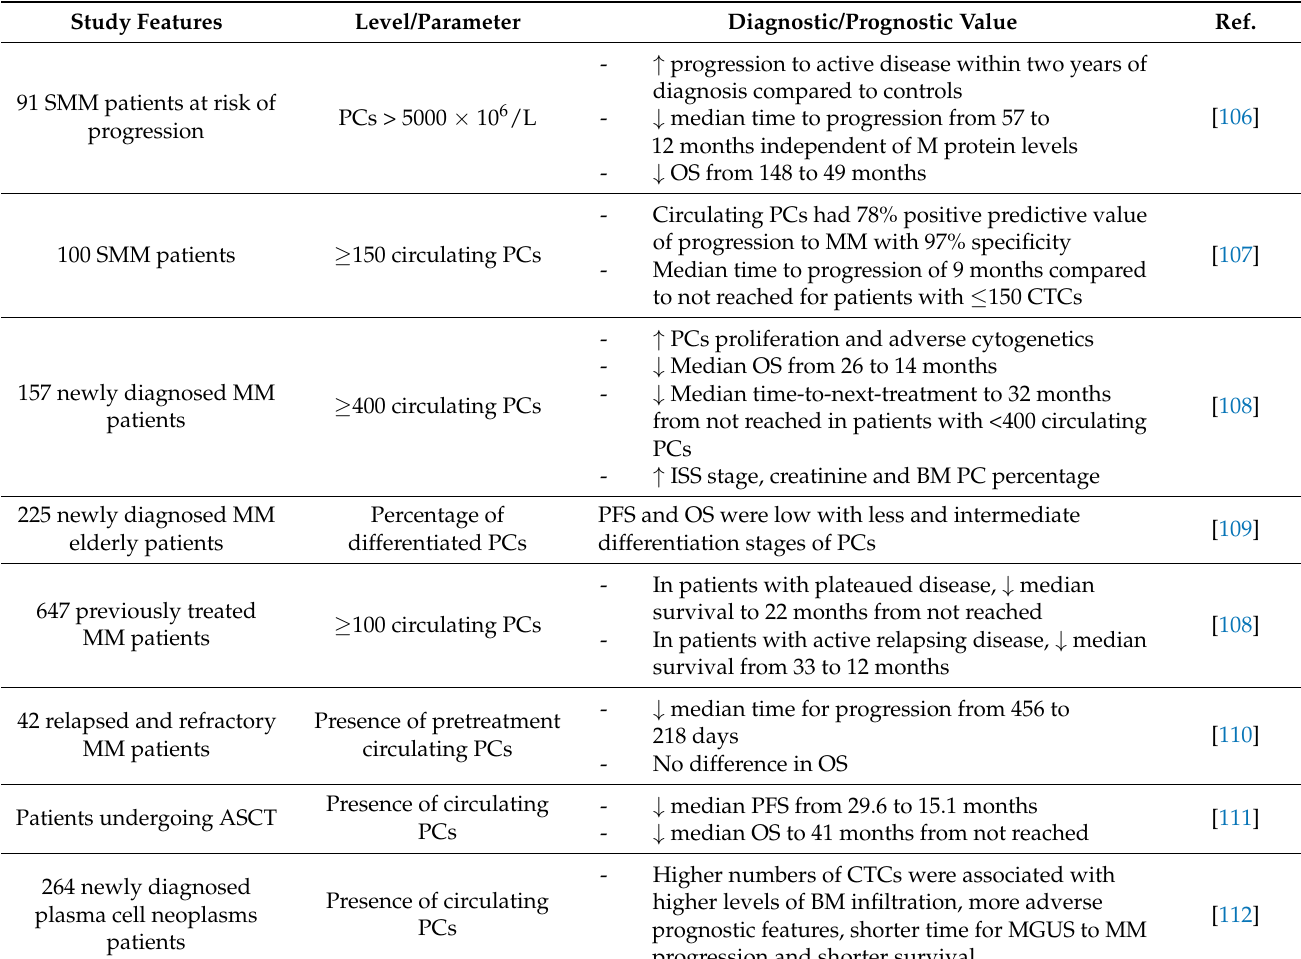
Table 2. Circulatory tumor cells and their potential prognostic role in SMM and newly diagnosed and relapsed MM. Study Features Level/Parameter Diagnostic/Prognostic Value